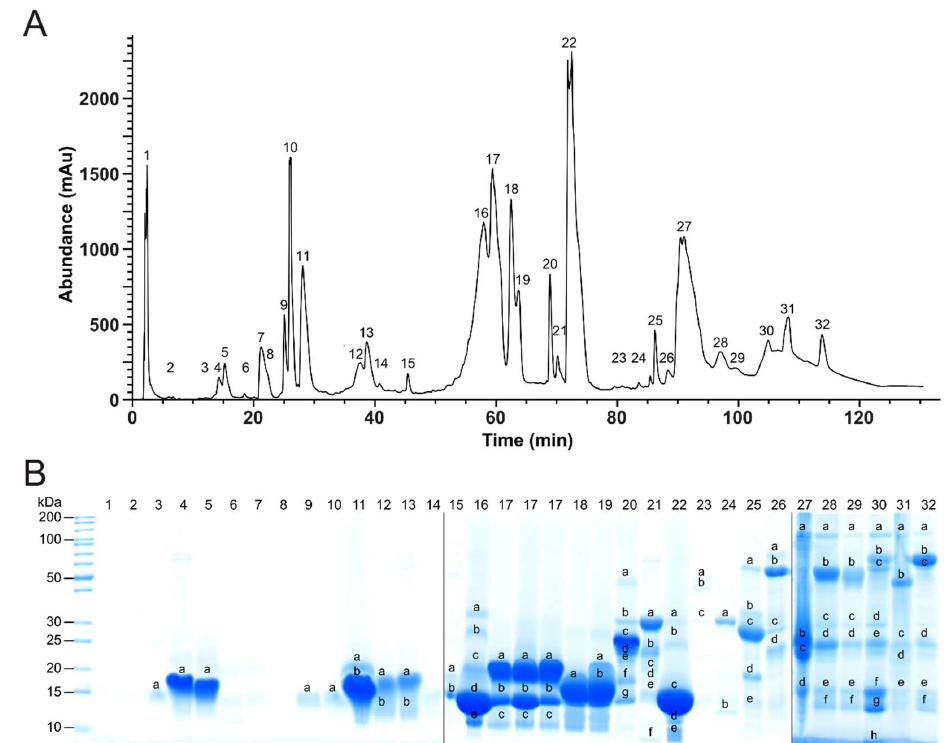
Figure 2. HPLC P. flavoviridis venom profile and fractions, separated by SDS-PAGE. ( A ) Crude venom from P. flavoviridis was separated on a Supelco Discovery BIO wide Pore C18-3 RP-HPLC column, and components were detected at λ = 214 nm. Collected fractions (assigned above the correlated peaks) were dried, and ( B ) separated by SDS-PAGE under reducing conditions (Coomassie staining). Alphabetically marked bands per line were excised for a subsequent tryptic in-gel digestion.